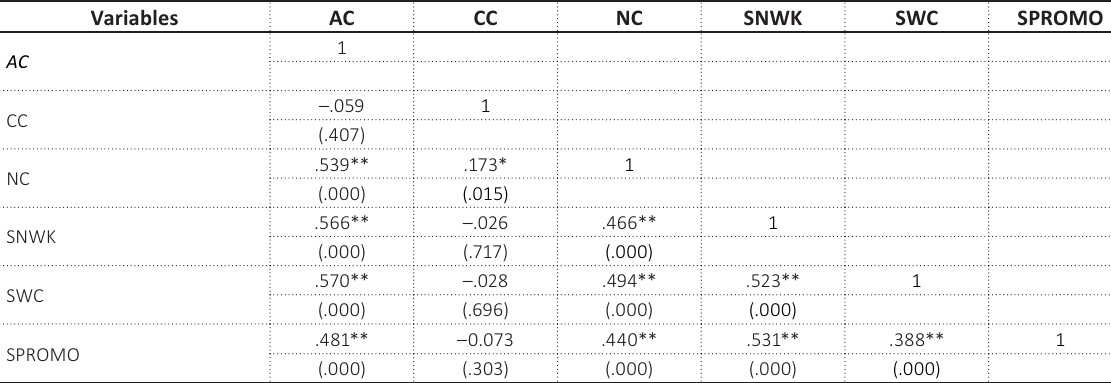
Table 2. Correlation matrix of response and predictor variables N = 199